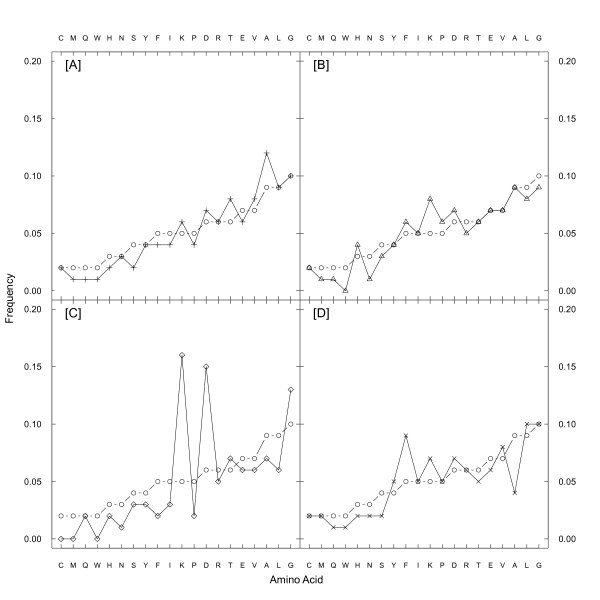
The amino acid composition of residues inferred as coevolving for different biochemical properties: (A) polarity, (B) Grantham distance, (C) charge and (D) volume, as shown by symbols "plus", "triangle", "rhombus" and "cross', respectively. The amino acids are ordered according to their frequency in all RBCL sequences, (as shown by "circle").